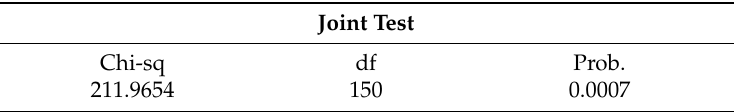
Table 4. VAR Residual Heteroskedasticity